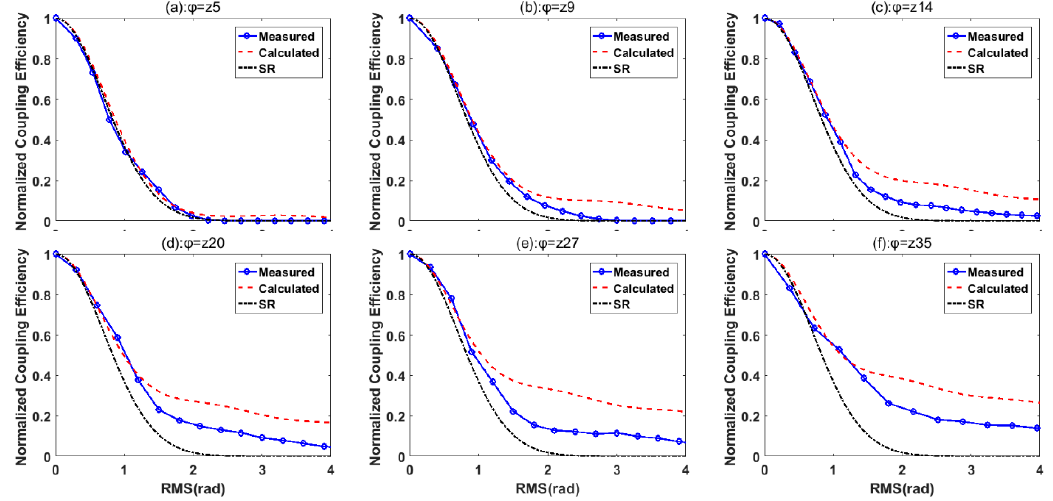
Figure 13. Relation between astigmatic aberrations and CE. ( a ) ϕ = Z5; ( b ) ϕ = Z9; ( c ) ϕ = Z14; ( d ) ϕ = Z20; ( e ) ϕ = Z27; ( f ) ϕ = Z35.